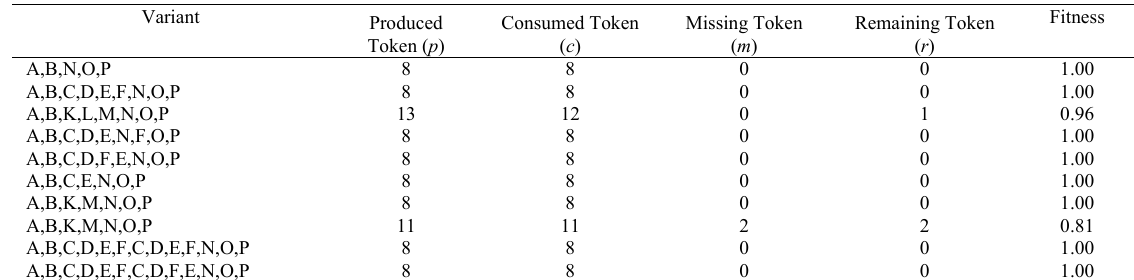
Algorithm 5. Conformance using Token-based replay TABLE 3 C ONFORMANCE C HECKING R ESULTS